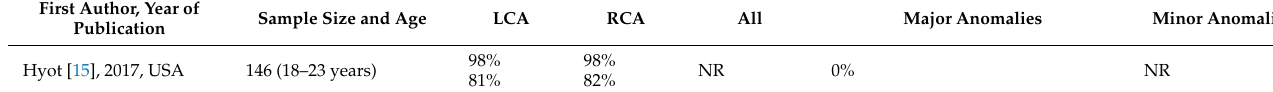
Table 2. Feasibility of coronary artery origin visualization by echocardiography and diagnosis of